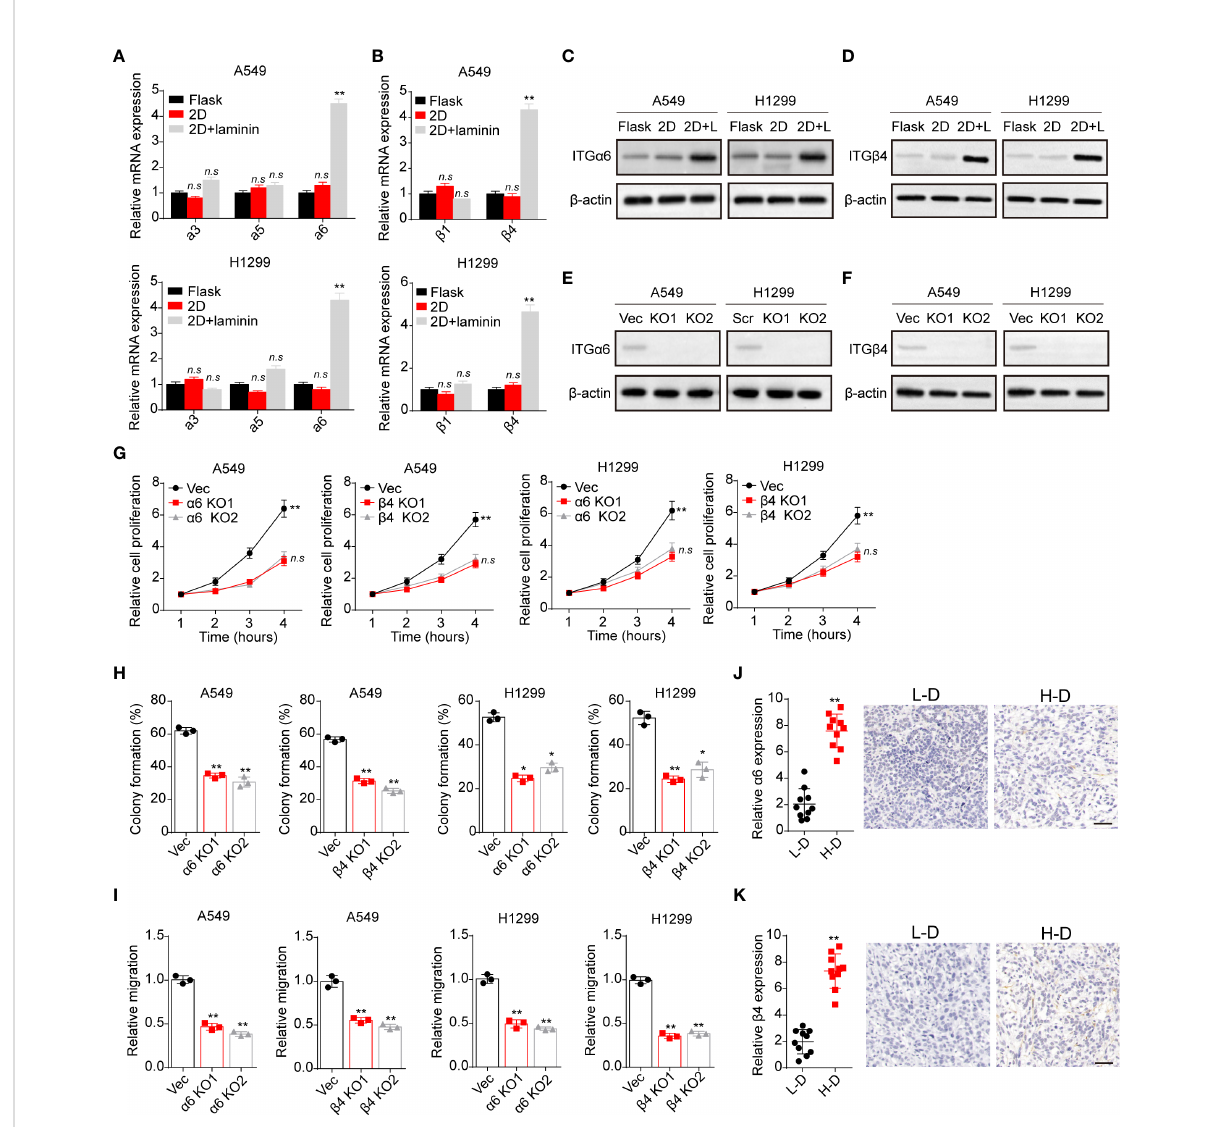
FIGURE 2 Laminin induced NSCLC development in an integrin a 6 b 4-dependent manner. (A) , A549 and NCI-H1299 cells were cultured on fl ask, 2D collagen gels or 2D collagen gels containing laminin for 5 days. Then the expression of integrin a 3, a 5 and a 6 in A549 and NCI-H1299 cells was detected using real-time PCR. (B) , the expression of integrin b 1 and b 4 in A549 and NCI-H1299 cells in (A) was examined. (C) , western blotting of integrin a 6 in A549 and NCI-H1299 cells in (A) was assessed. (D) , western blotting of integrin b 4 in A549 and NCI-H1299 cells in (A) was evaluated. (E) , integrin a 6 knockdown in A549 and NCI-H1299 cells was evaluated with western blotting. (F) , integrin b 4 knockdown in A549 and NCI-H1299 cells was evaluated with western blotting. (G) , integrin a 6 and b 4 were knockdown separately in A549 and NCI-H1299 cells. Then cells were cultured on 2D collagen gels containing laminin for 5 days. Next, A549 and NCI-H1299 cells were collected and the cell proliferation in 72 hours was examined by CCK-8 analysis. (H) , the colony formation analysis of A549 and NCI-H1299 cells in (G) . (I) the relative migration cell numbers of A549 and NCI-H1299 cells in (G) using transwell analysis. (J) , immunohistochemical staining of integrin a 6 in high degree (H-D) and low degree (L-D) tumor tissues from NSCLC patients. The scale bar is 50 m m. (K) immunohistochemical staining of integrin b 4 in high degree (H-D) and low degree (L-D) tumor tissues from NSCLC patients. The scale bar is 50 m m. *p < 0.05; **p < 0.01; n.s, no signi fi cant